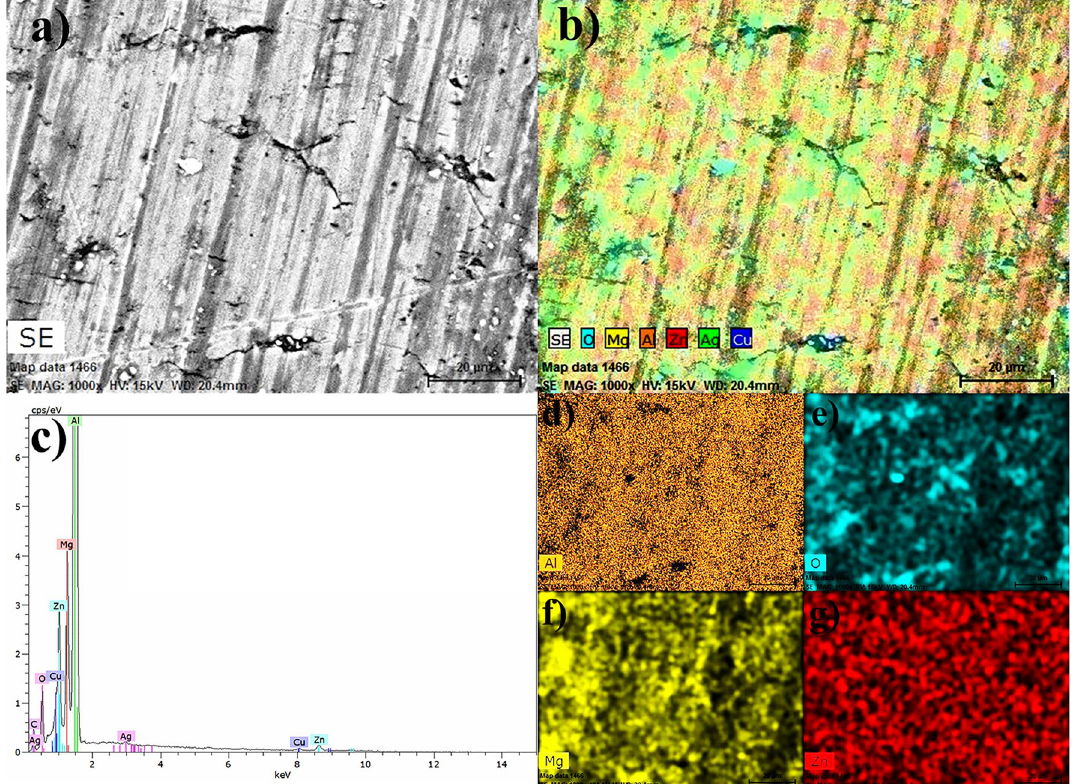
Figure 5. SME and EDS analyses of an aluminum 3003 cleaned